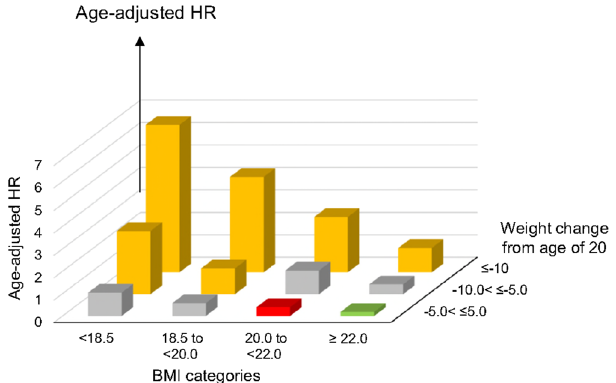
Figure 2. Hazard ratio (HR) of COPD mortality based on the four BMI and four weight change categories. The red bar represents the reference group (5.0 < , < 5.0 kg weight change and 20.0 to < 22.0 kg/m 2 BMI). Yellow bars indicate categories with significantly greater HR, grey bars represent categories that did not show statistically significant difference, and green bars represent a statistically significant smaller HR compared to the reference group. This figure suggests that BMI and weight loss are independent risks for COPD